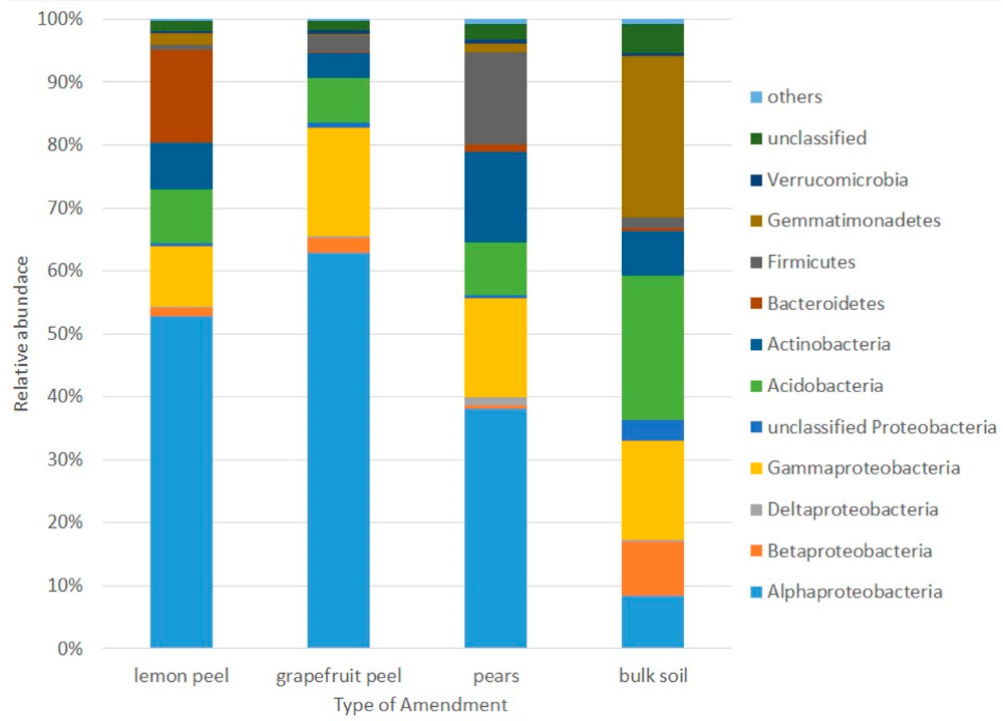
Figure A1. Total community composition in soils after amendment with natural materials represented as bacterial phyla or classes in the case of Proteobacteria. Bulk soil was not amended by any